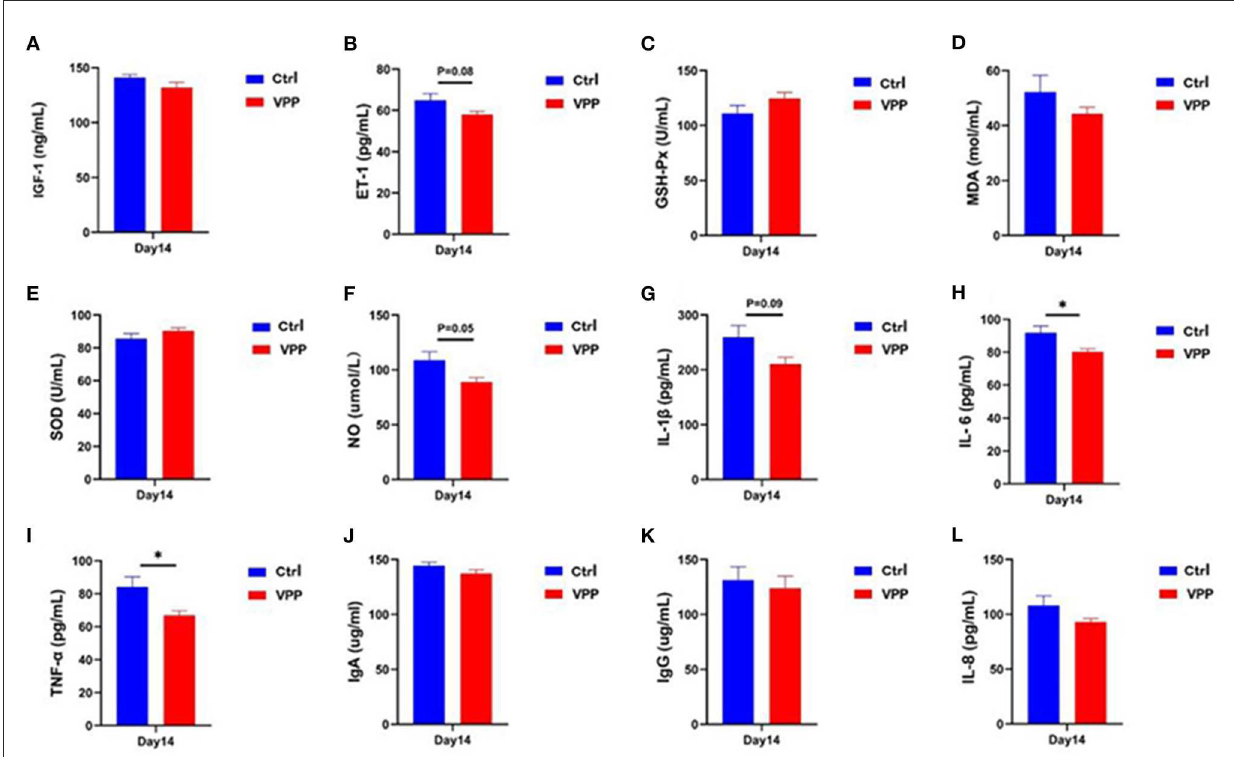
FIGURE2 Effects of VPP on serum biochemical indices of pre-weaning calves. Concentrations of (A) insulin-like growth factor 1 (IGF-1), (B) endothelin 1 (ET-1), (C) glutathione peroxidase (GSH-Px), (D) malondialdehyde (MDA), (E) superoxide dismutase (SOD), (F) nitric oxide (NO), (G) interleukin-1 β (IL-1 β ), (H) interleukin-6 (IL-6), (I) tumor necrosis factor- α (TNF- α ), (J) immunoglobulin A (IgA), (K) immunoglobulin G (IgG), and (L) interleukin-8 (IL-8). Values are means ± SD, n = 10. *Significant difference between group ( P < 0.05).